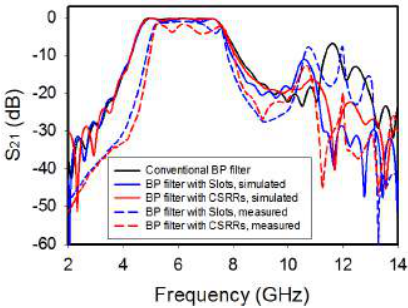
Figure 6: Simulated and measured insertion loss of the pro- posed C-band bandpass filter